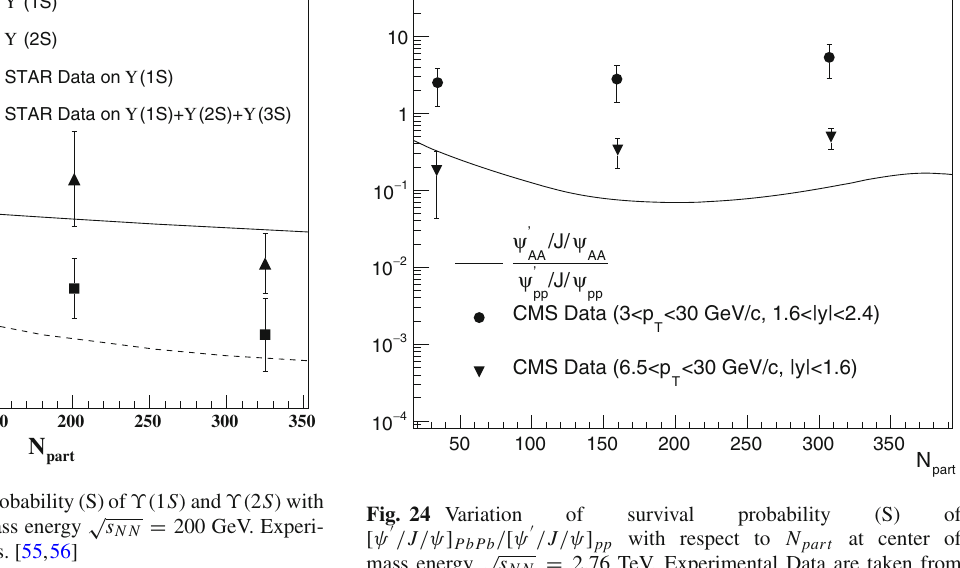
√ s NN = 200 GeV. Experi-